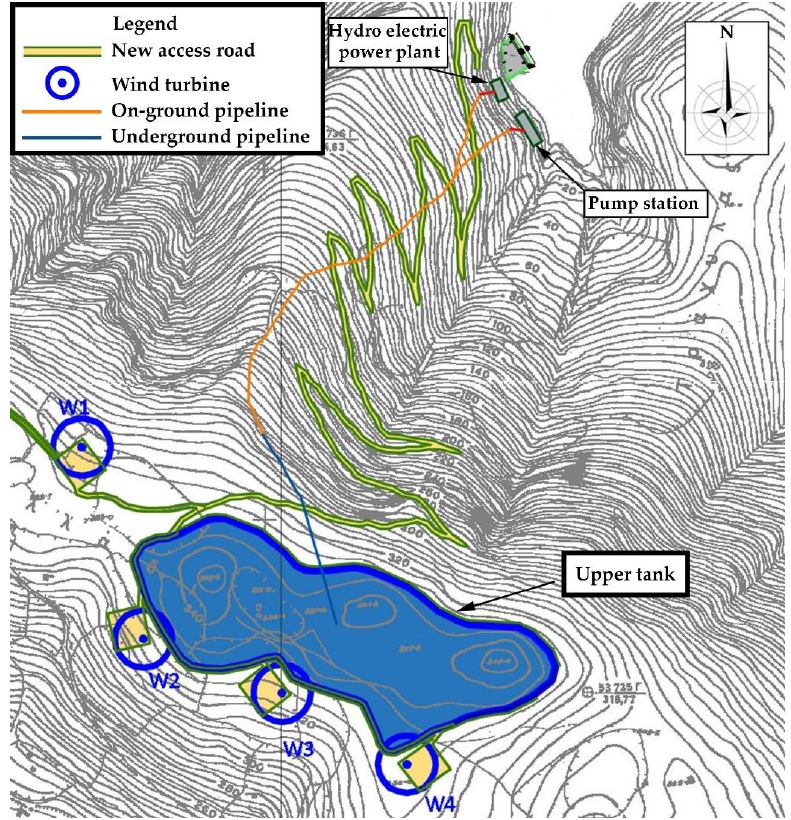
Figure 8. The siting of the hybrid power plant.